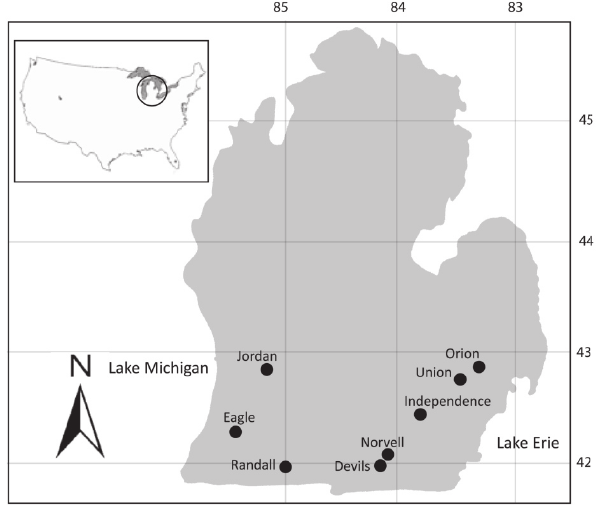
Fig. 1. – Largemouth bass ( Micropterus salmoides ) were collected from eight collection sites in the Lower Peninsula of Michigan between July 2002 and September